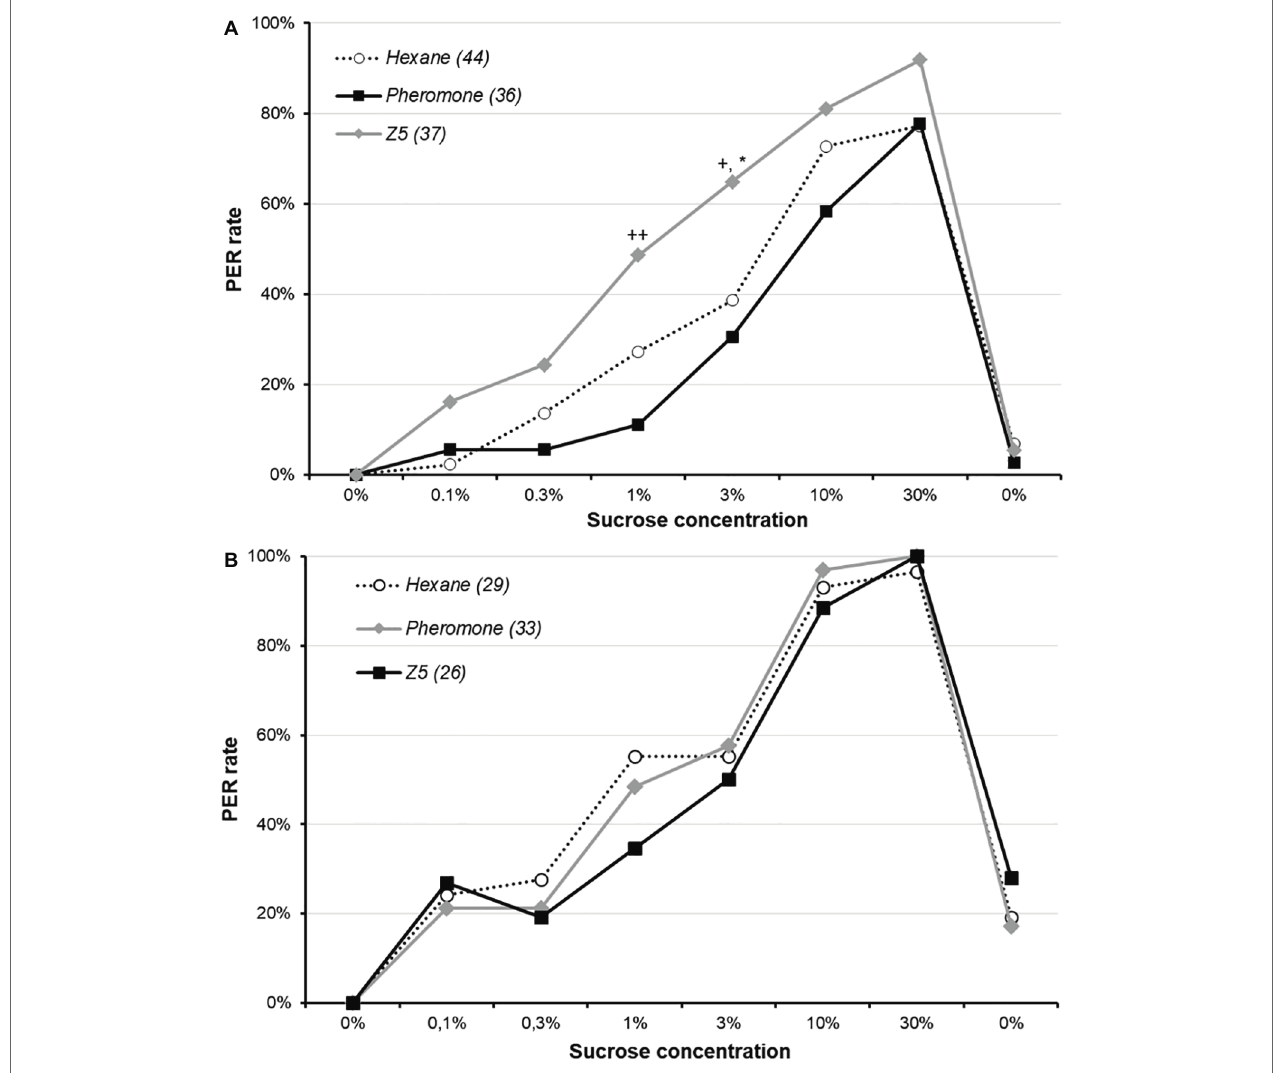
FIGURE 1 | Effect of sex-pheromone on sucrose responsiveness in male Agrotis ipsilon . The x-axis reports the successive sucrose solutions, and the y-axis the PER rate (i.e., percentage of animals responding by a PER). Each curve corresponds to a treatment (i.e., pre-exposure to hexane, pheromone or Z5), and values in parenthesis are the sample sizes. In part A , animals were exposed to either hexane, conspecific sex-pheromone or Z5 during 15 min before undertaking the sucrose responsiveness assay. In part B , the pre-exposure was done for 15 min 24 h before the sucrose responsiveness assay. Stars denote a significant difference between Z5 and hexane (* χ 2 , adjusted p < 0.050), and crosses between Z5 and conspecific sex-pheromone ( χ 2 ; +: adjusted p < 0.050; ++: adjusted p <